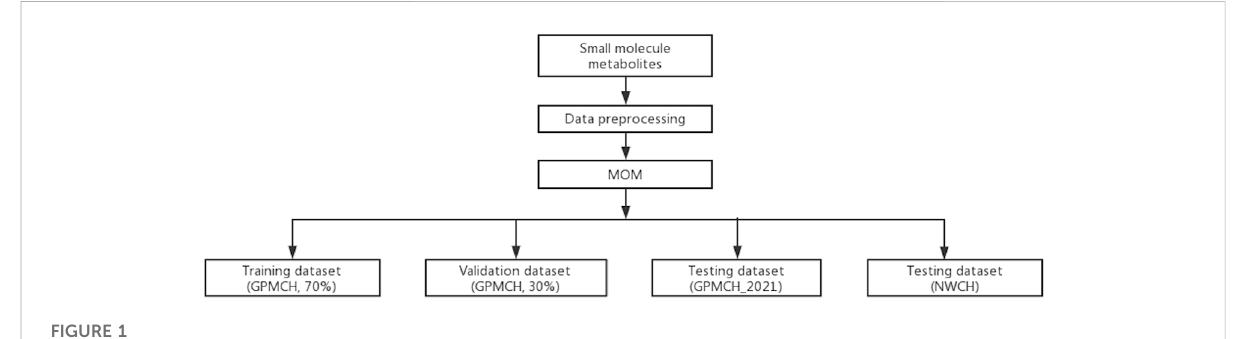
FIGURE 1 The fl ow chart of dataset processing and